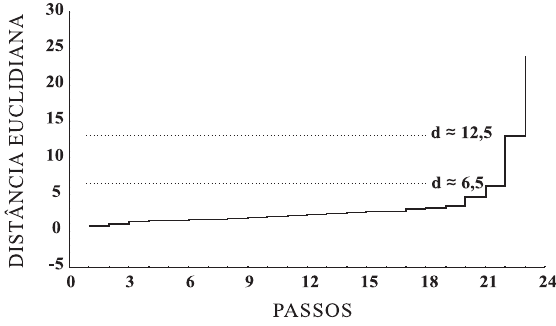
Figura 2. Representação da variação expressiva da distância euclidiana entre as variáveis conside- radas que permitiu a separação de